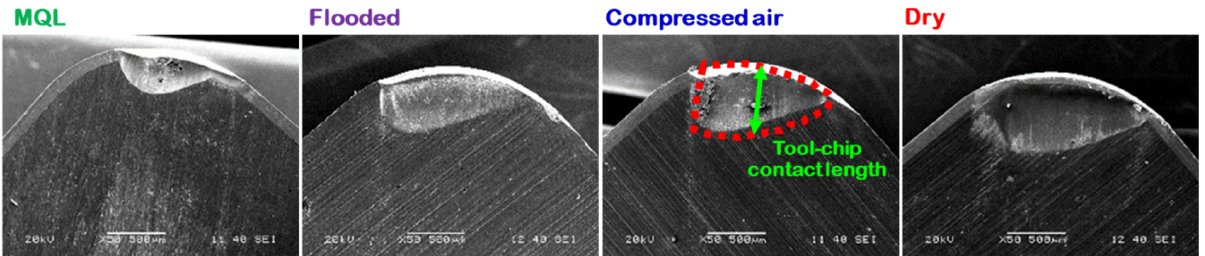
Figure 5. Crater wear due to tool-chip sliding contact length under several turning environments at v = 87 m/min, and f = 0.24 mm/rev.